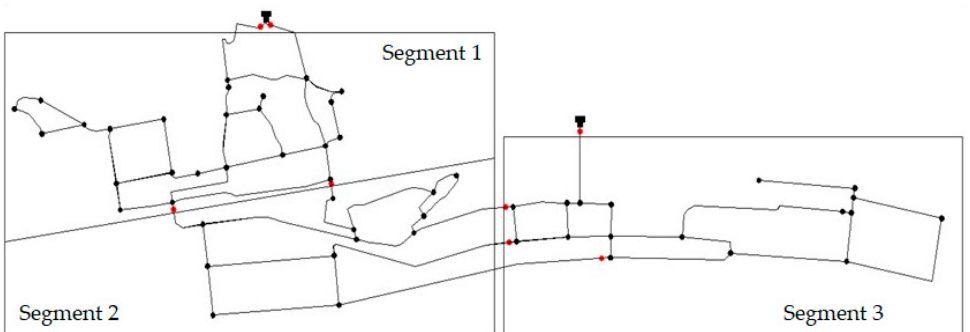
Figure 2. Initial condition: 8 shut-off valves and 3 segments.